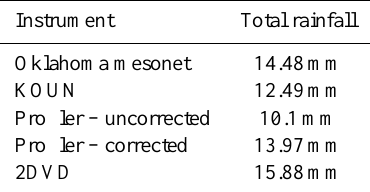
Table 4. Total rainfall accumulations for the 13 July 2007 event. Instrument Total